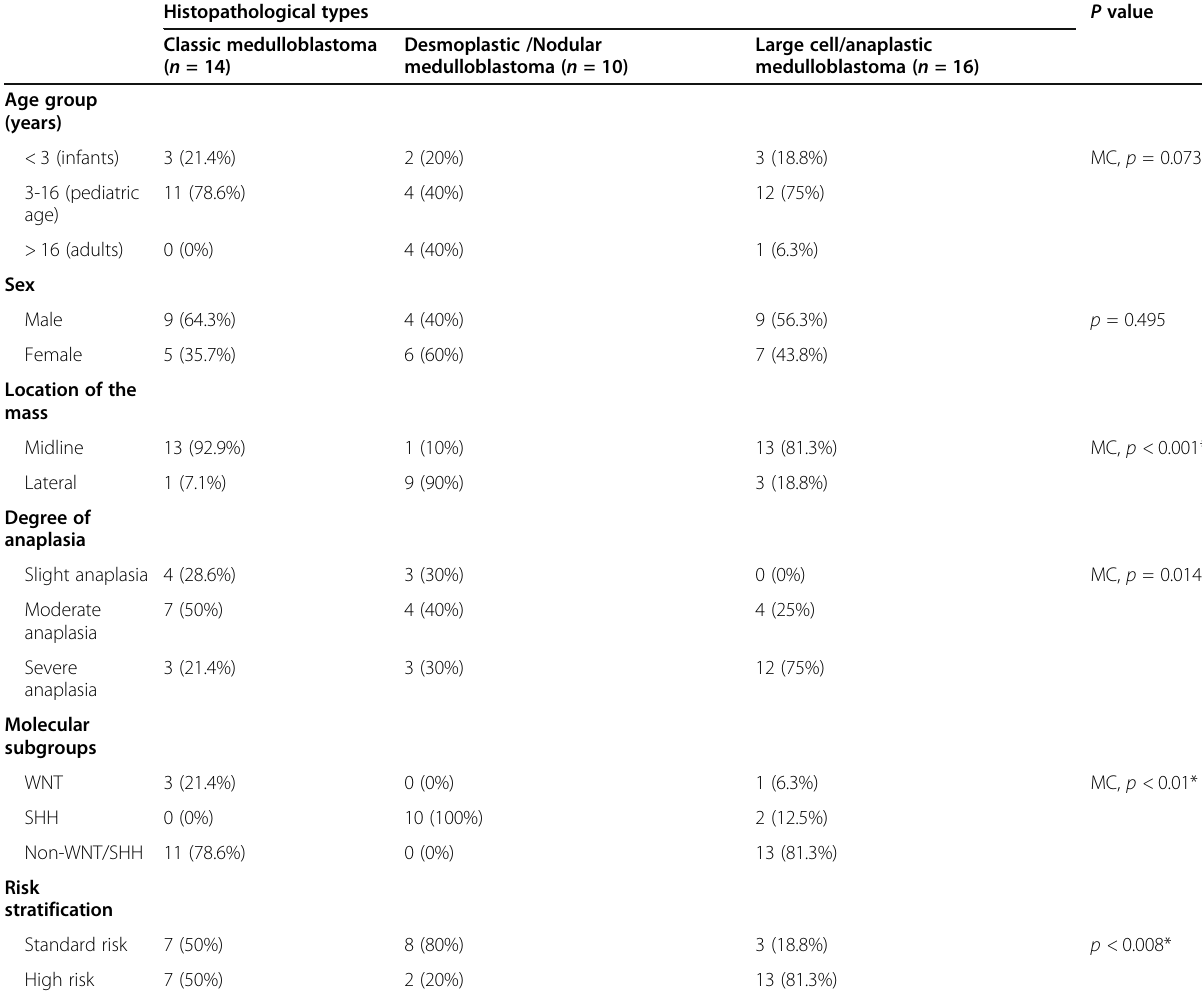
Table 3 Relation of histopathological types to clinicopathological parameters Histopathological